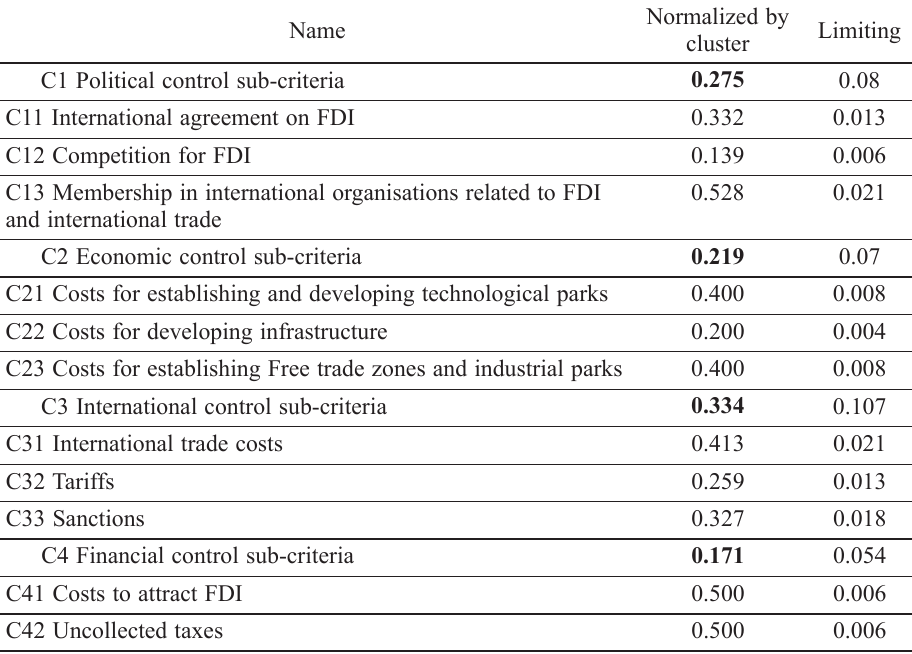
Table 10. Priorities of the elements in the cost sub-network Name